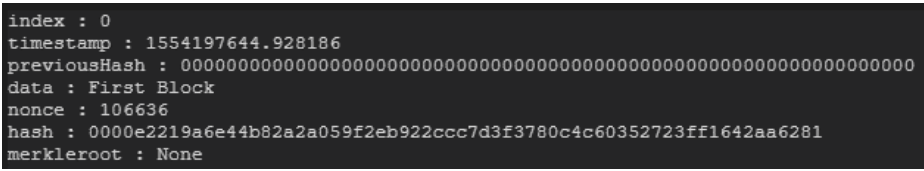
Figure 14. Running program of the blockchain.